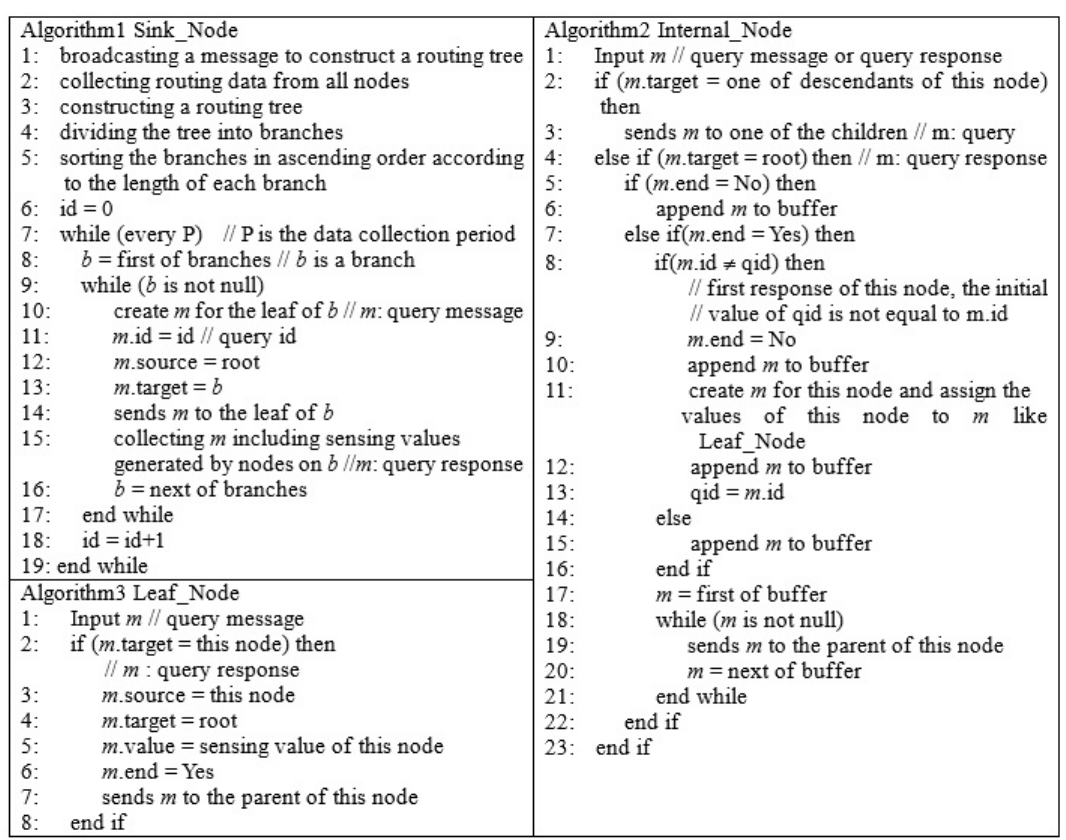
Figure 6. Algorithms for sink, internal and leaf